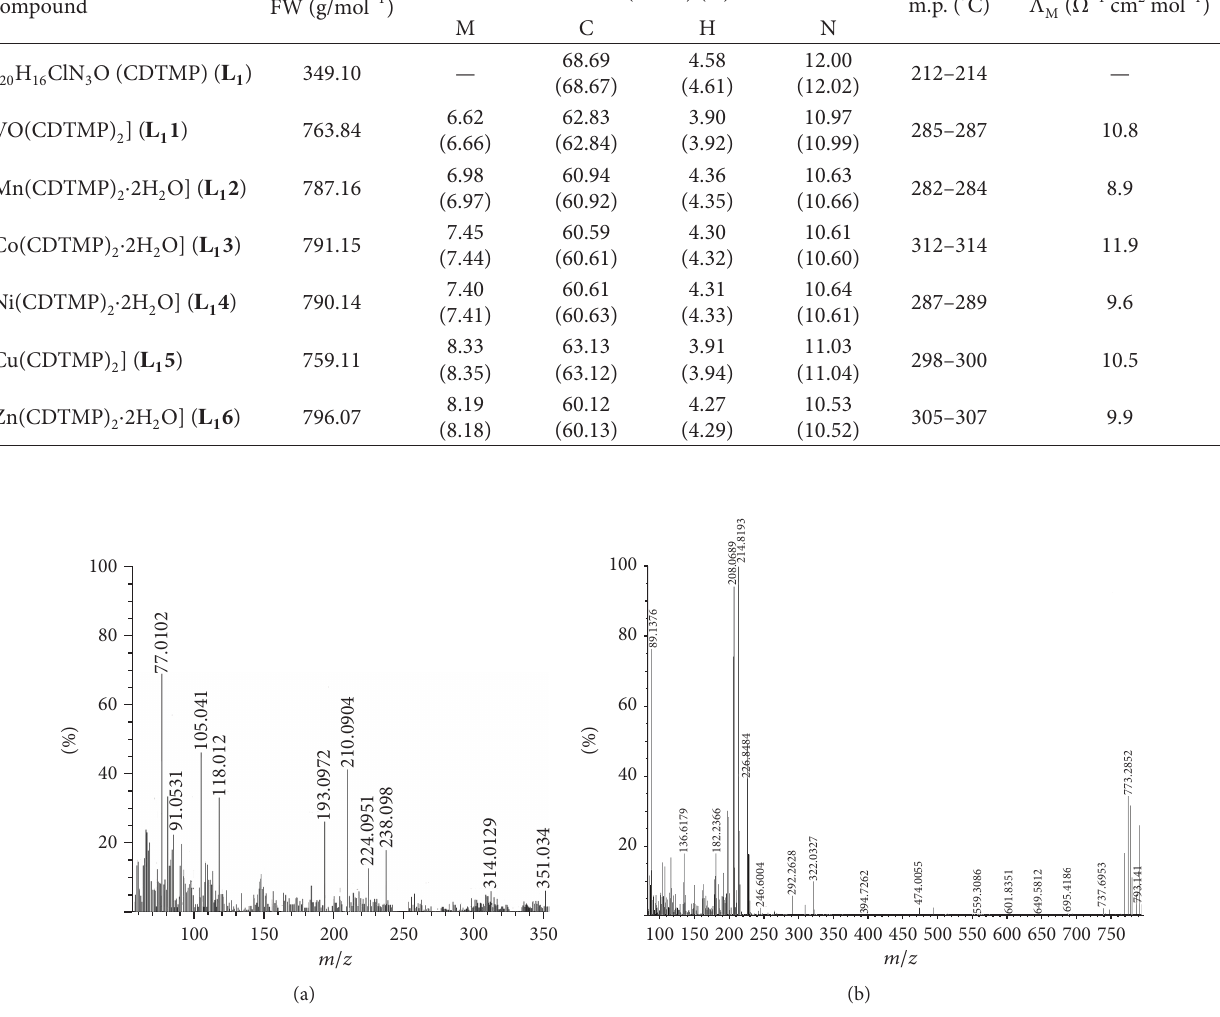
), and its metal(II) 𝐋𝐋 𝟏𝟏